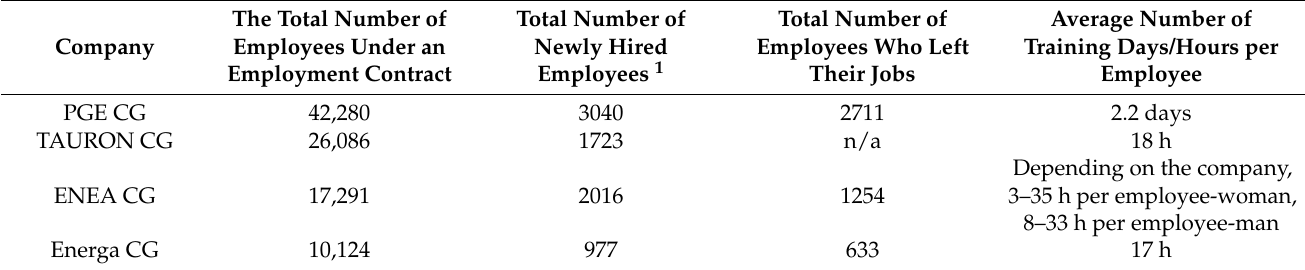
Table 7. Human resources in the leading capital groups generating electricity in Poland in the year 2019.